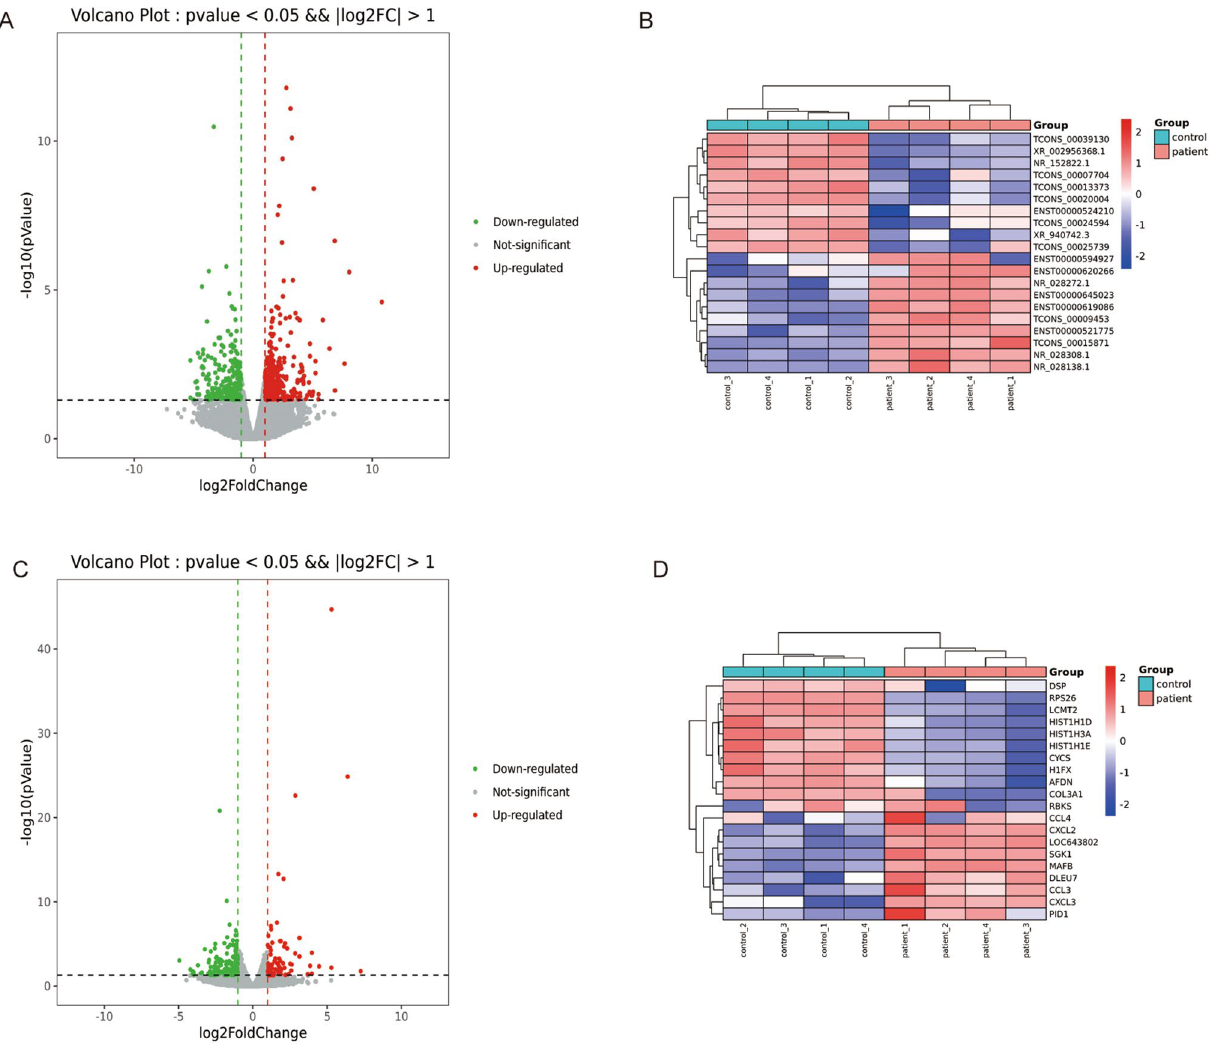
Figure 1. Differentially expressed lncRNAs (DE-lncRNAs) and mRNAs (DE-mRNAs) in the BD versus control groups. ( A ) Volcano plot of DE-lncRNAs in the BD versus control groups. ( B ) Heatmap of DE-lncRNAs in the BD versus control groups. Gray dots represent the genes that are not significantly differentially expressed. Green and red dots indicate significantly upregulated and downregulated genes, respectively. ( C ) Volcano plot of DE-mRNAs in the BD versus control groups. ( D ) Heatmap of DE-mRNAs in the BD versus control groups. Rows and columns represent the genes and samples (|log twofold change|≥ 1.0 and P value ≤ 0.05). Volcano plots and heatmaps of DE-RNAs were generated by R